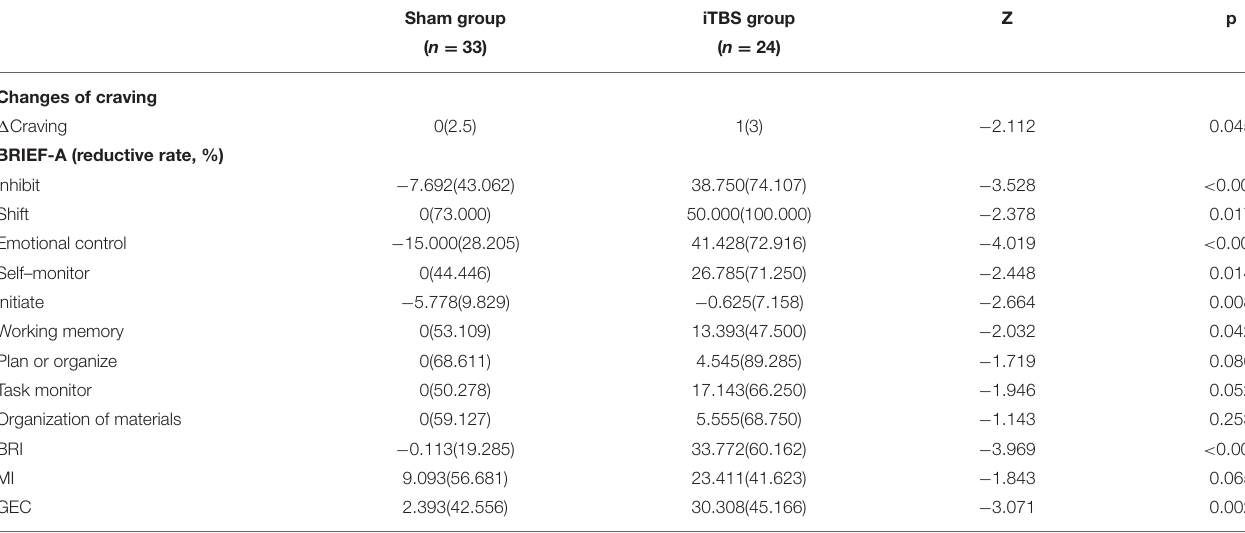
TABLE 4 | Comparisons of reduction rate of BRIEF-A and changes of craving in sham group and iTBS group after